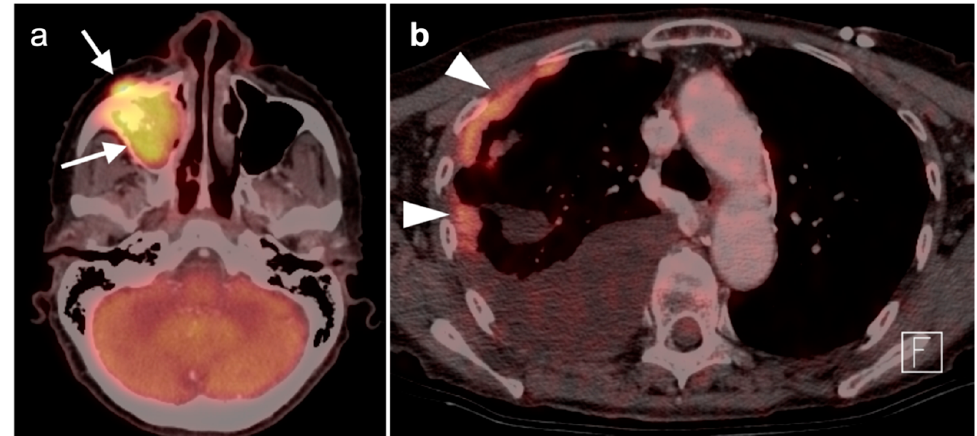
Figure 22. Sinonasal undifferentiated carcinoma (SNUC). ( a ) An intensely hypermetabolic primary tumor in the right maxillary sinus on FDG PET ‐ CT shows extension anteriorly into the pre ‐ maxillary soft tissues (white arrow). ( b ) There are multiple pleural metastases (( b ), white arrowheads) with a malignant right pleural effusion.